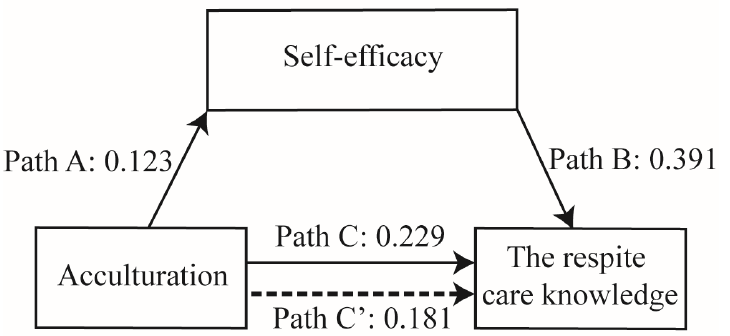
Figure 1. Mediating effect of self-efficacy between acculturation and respite care knowledge. Non- standardized path coefficients are presented. A partial mediating effect was found for self-efficacy.